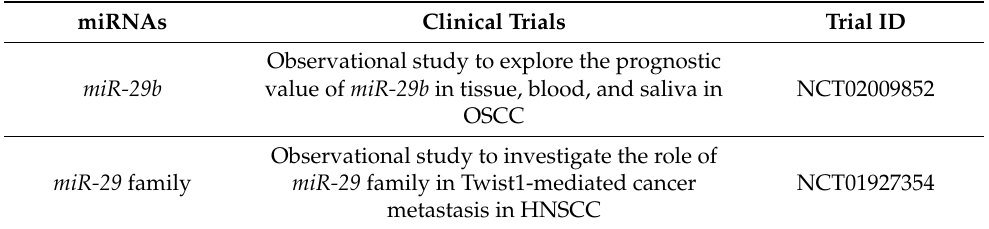
Table 4. List of miRNA-related clinical trials in head and neck squamous cell carcinomas (HNSCCs). miRNAs Clinical Trials Trial ID Observational study to explore the prognostic miR-29b value of miR-29b in tissue, blood, and saliva in NCT02009852 OSCC Observational study to investigate the role of miR-29 family miR-29 family in Twist1-mediated cancer metastasis in HNSCC